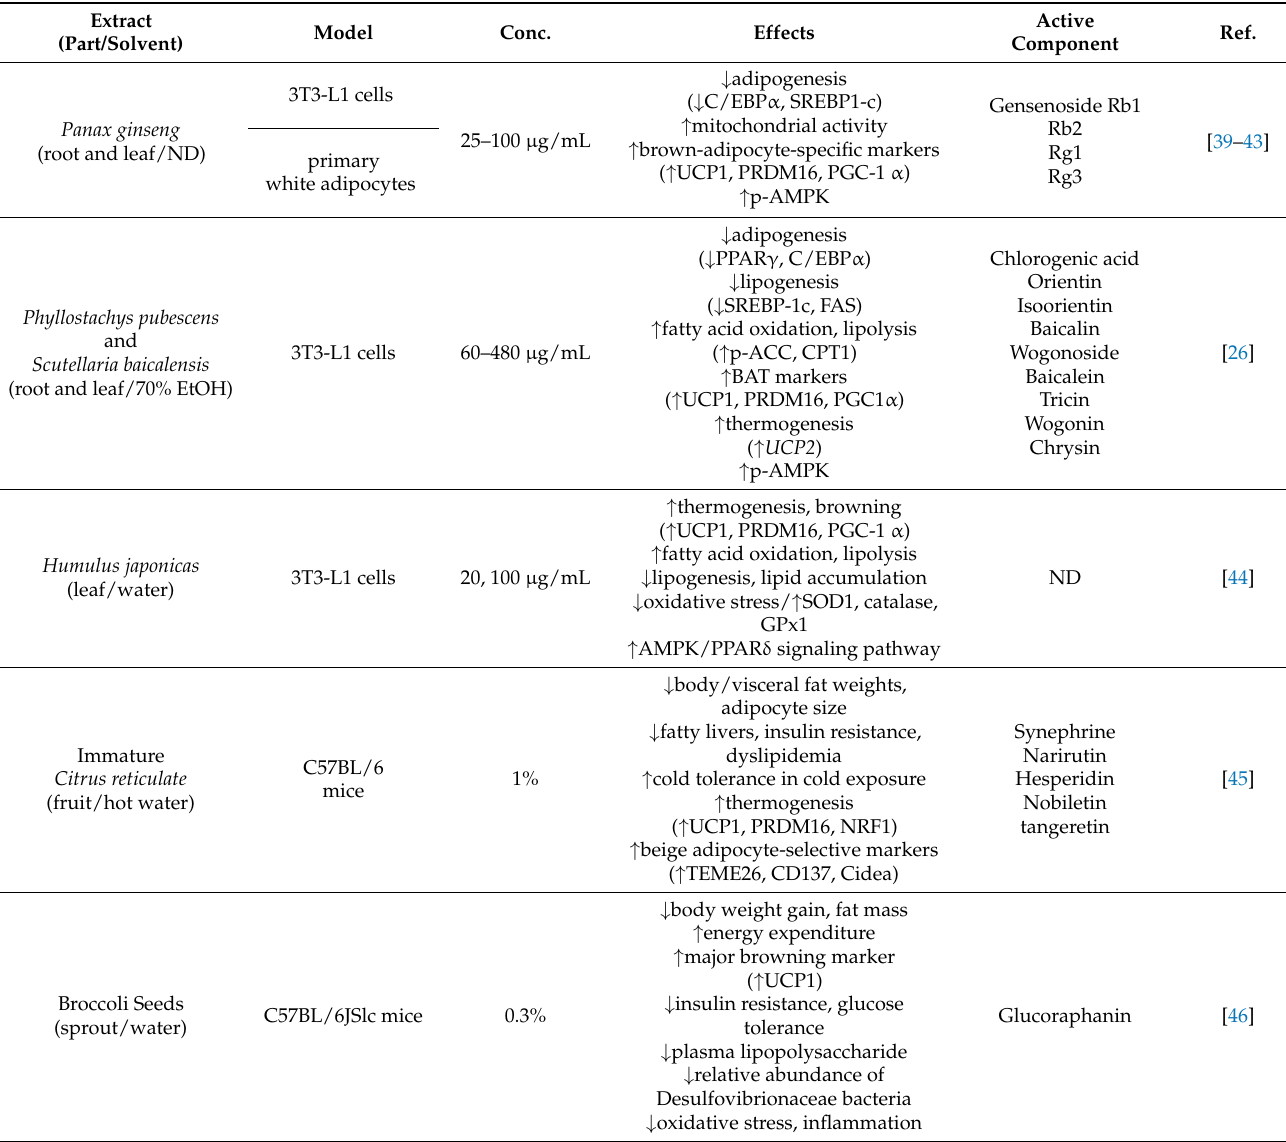
Table 2. Plant extracts to induce adipocyte